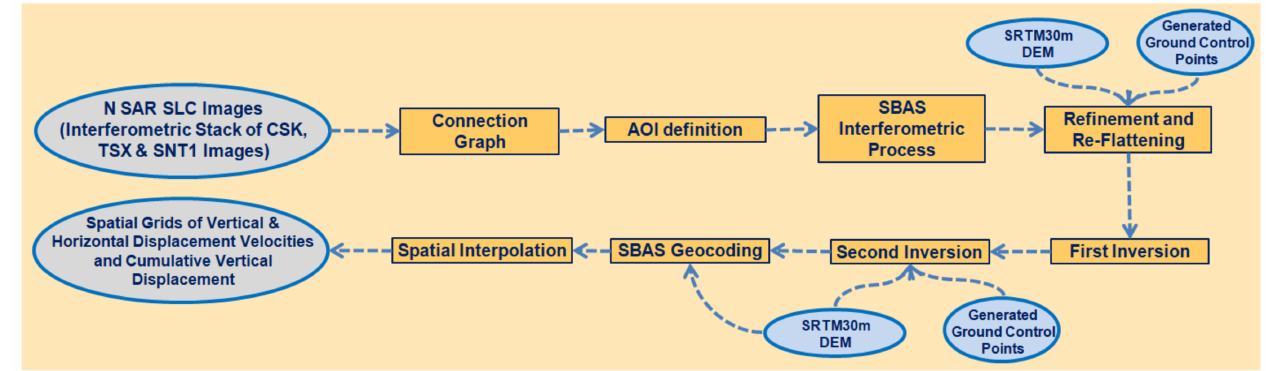
Figure 4. SBAS-InSAR interferometric processing